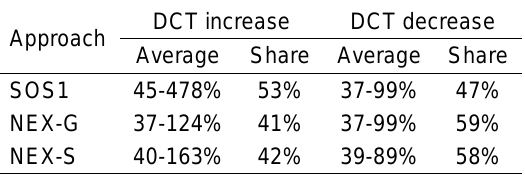
Table 7. Summary of comparisons by outcome: share of problems (%) and average DCT difference in relation to the average DCT for the same time step duration